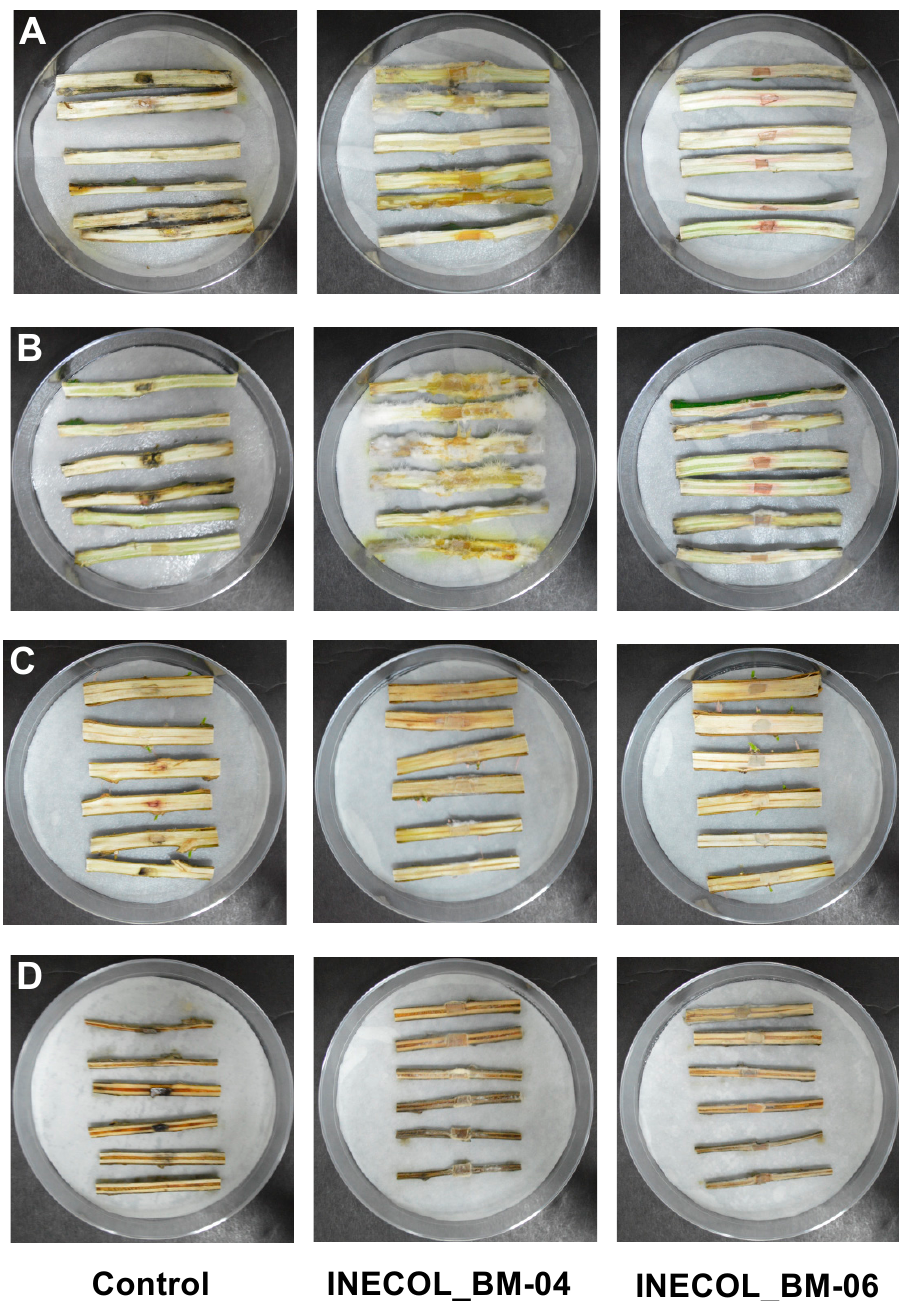
Figure 6. Pathogenicity screening of Fusarium sp. INECOL_BM-04 and Fusarium sp. INECOL_BM-06 in vascular tissue of citrus and forest species. ( A ) Citrus latifolia. ( B ) Citrus sinensis . ( C ) Salix lasiolepis. ( D ) Populus nigra. The photographs were taken at 12 dpi.